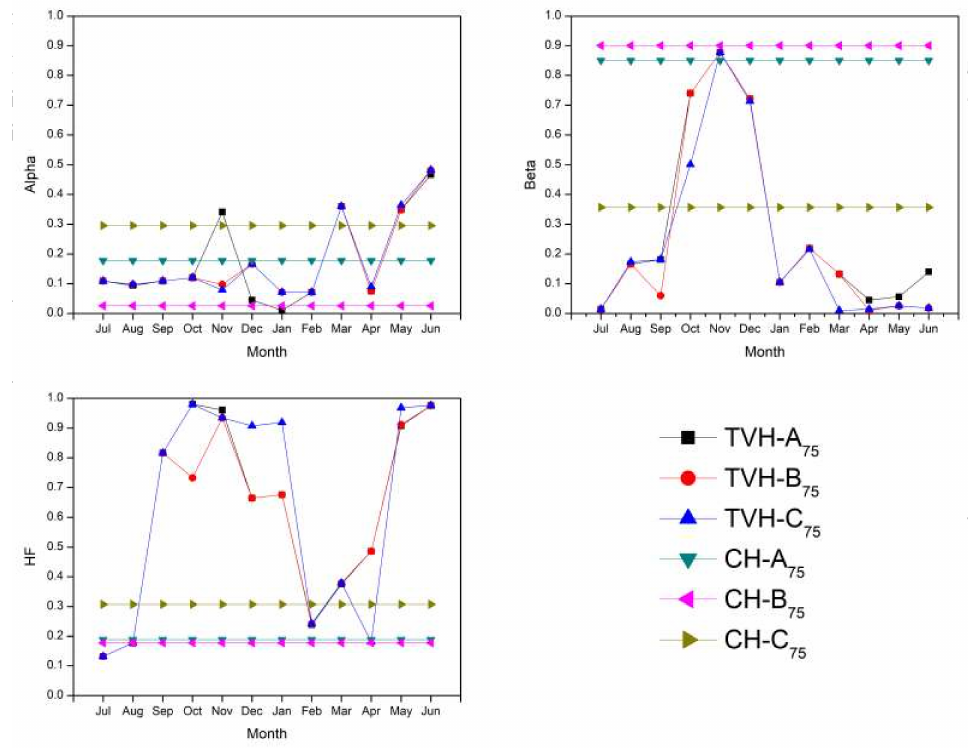
Figure 7. Time-varying hedging (TVH) and constant hedging (CH) parameters (alpha, beta and hedging factor) for modified two-point hedging policy—A comparison between the selected pareto-optimal solutions for 75% demand